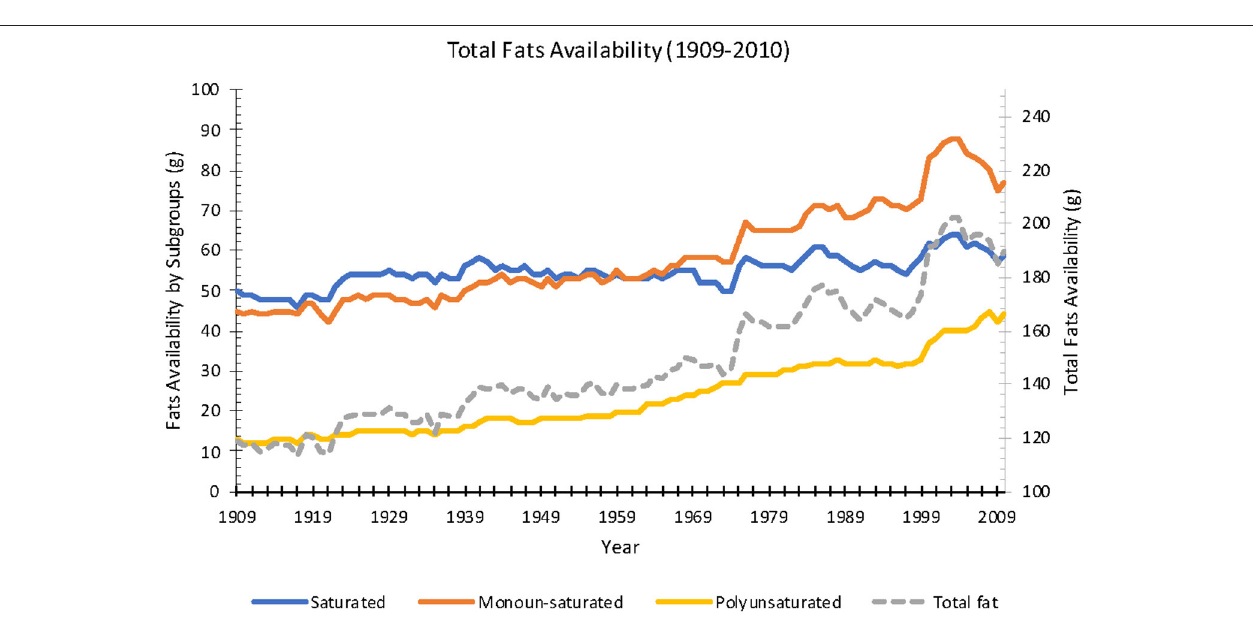
FIGURE 2 | Annual fats availability per capita from 1909 to 2010 (Source: USDA ERS